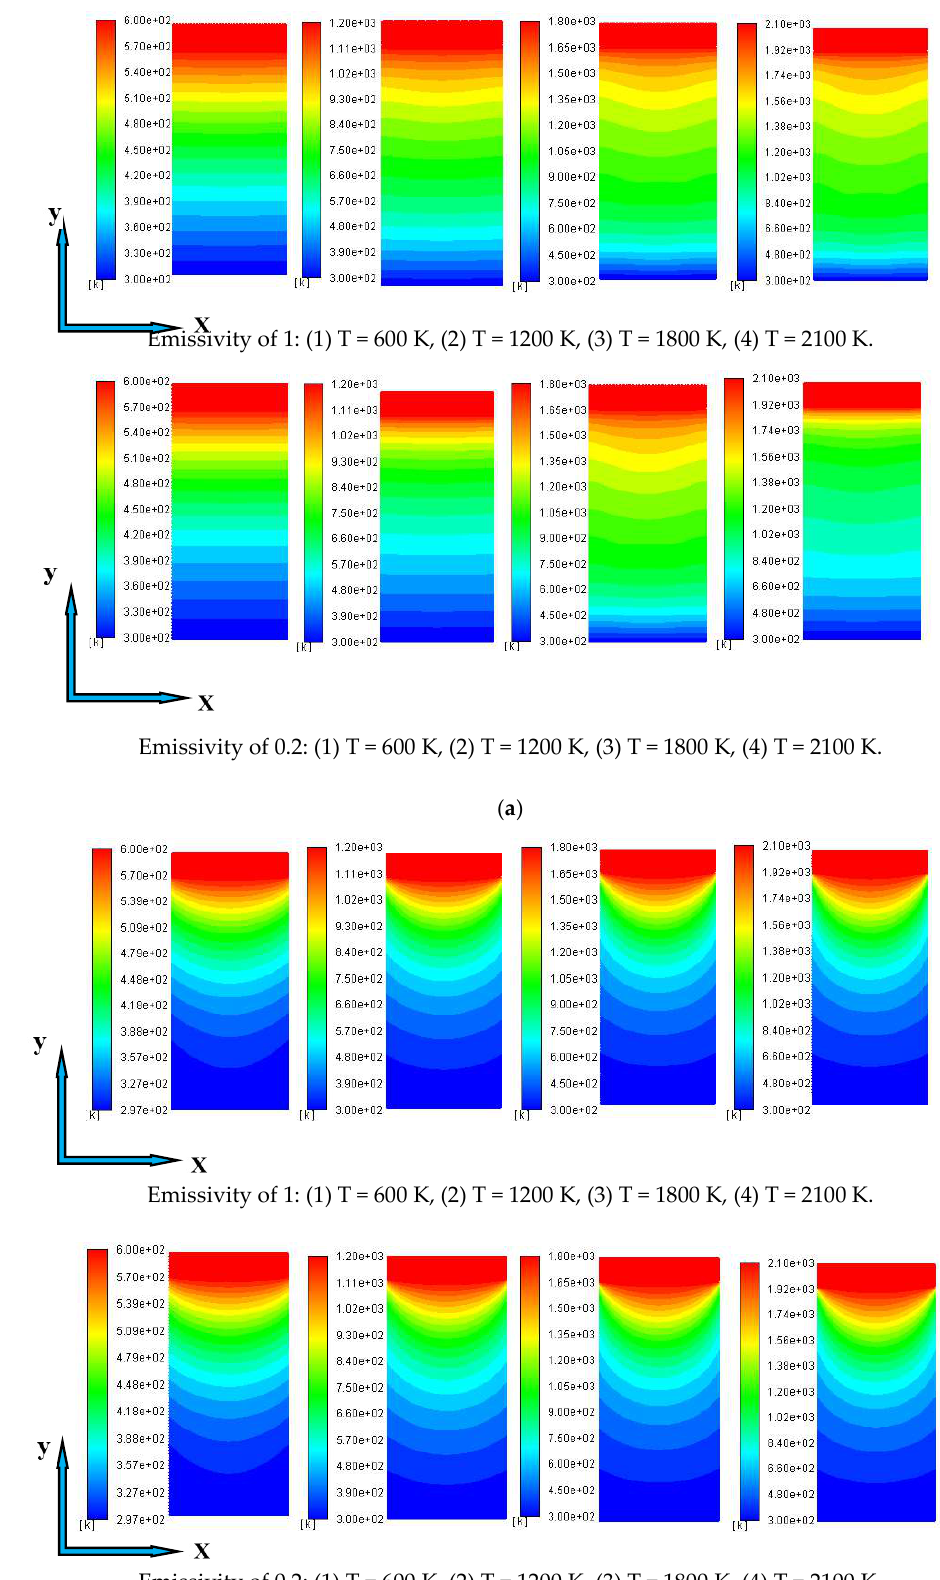
Figure 4. Temperature diagrams with different boundary temperatures at the emissivity of 1 and 0.2: ( a ) β = 50 m −1 , ( b ) β = 100,000 m −1 .